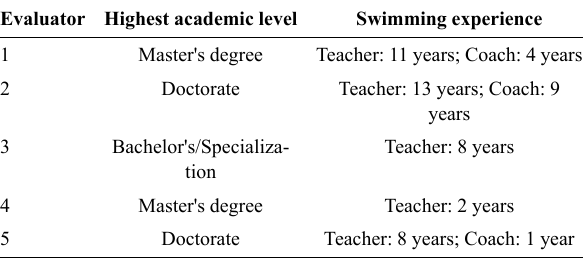
Table 1 - Evaluators’ academic education level and swimming experi- ence. Evaluator Highest academic